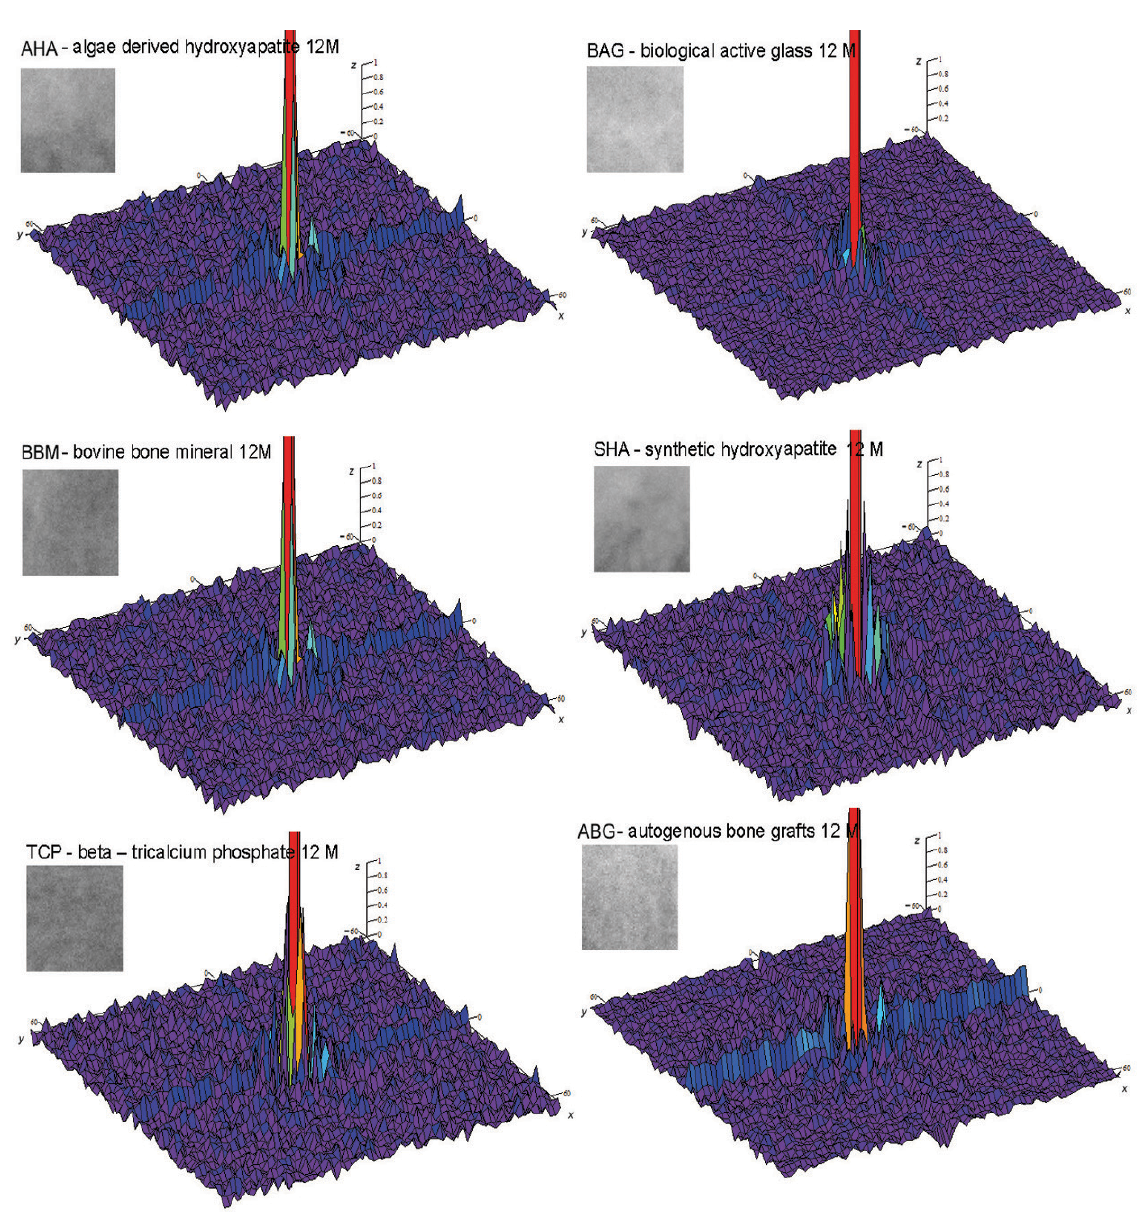
Figure 1b. Results of Fourier Transformation: 3 dimension presentation of amplitude distributions the Fourier Transformation of analysed images; (axes: x,y – spatial frequencies, z – amplitude). Abbreviation: 12M – twelve months after